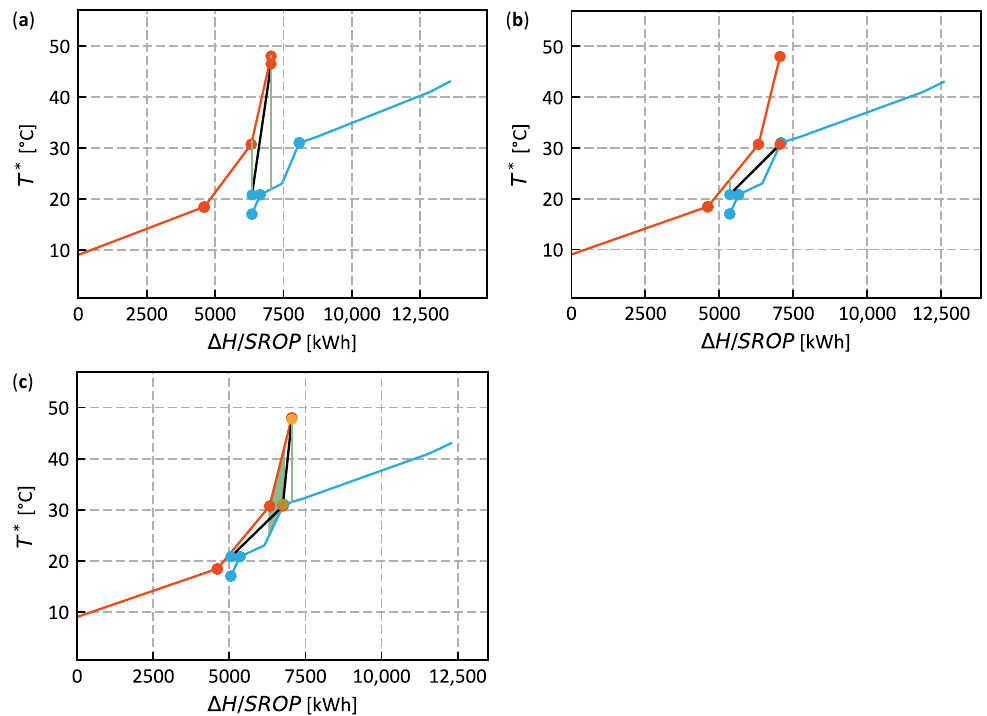
Figure 10. ISSP of Industry Case Study with IHR of ( a ) 700 kWh, ( b ) 1700 kWh, and ( c ) 2000 kWh, with two AZs, two AZs, and four AZs,